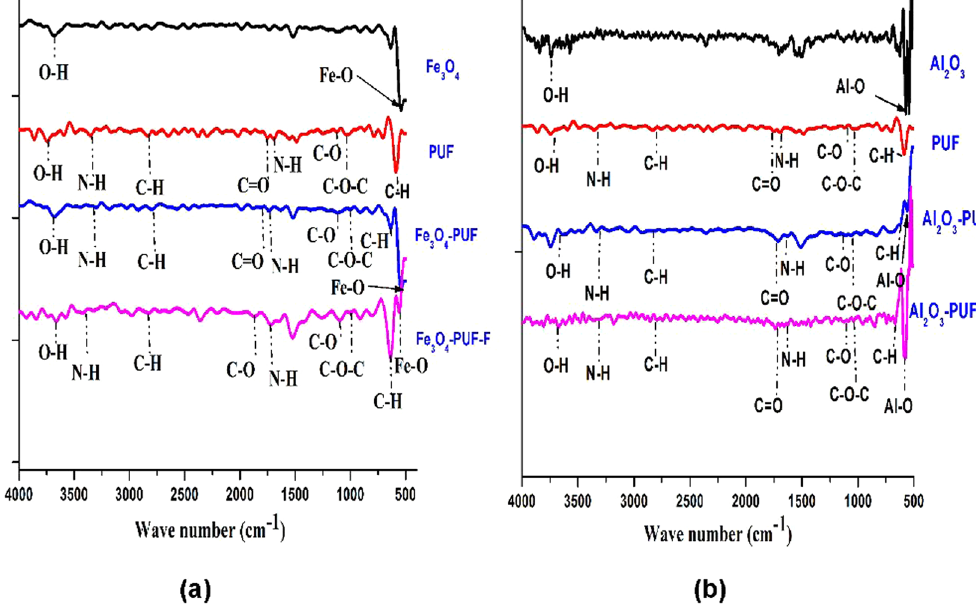
Figure 3. FTIR spectra of ( a ) Fe samples ( b ) Al